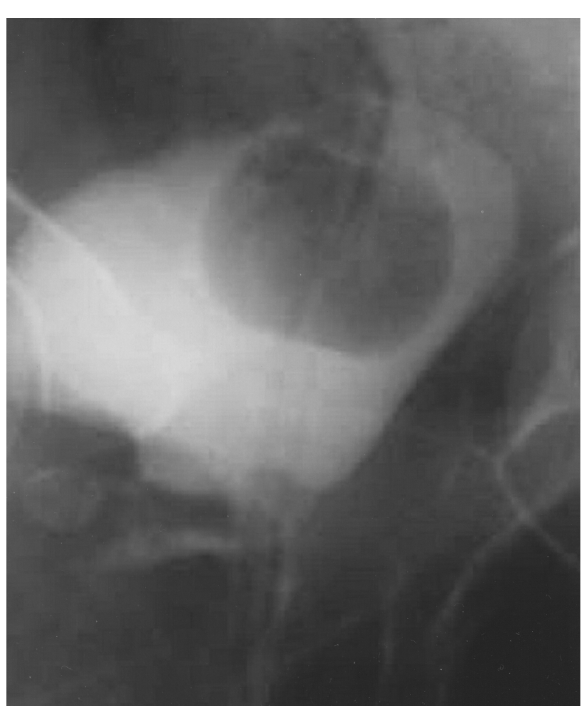
Figure 4 - Cystographic control showing minimum extravasa- tion of contrast medium and descending of bladder to its ana- tomical